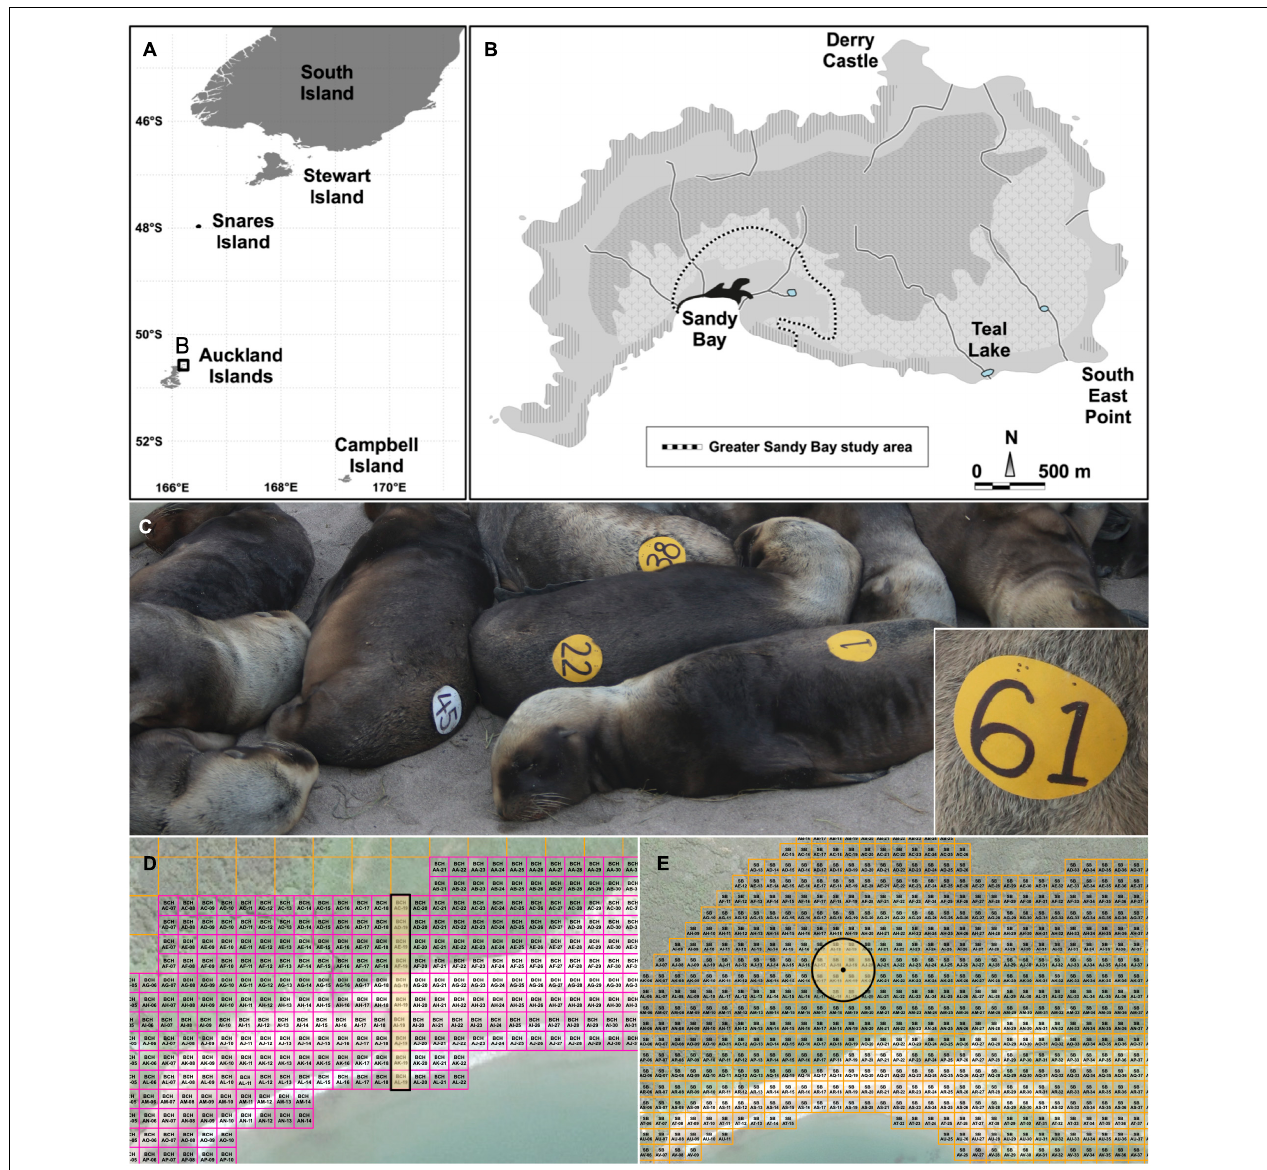
FIGURE 1 | Summary of methodology used in data collection for analysis of risk factors for mortality in New Zealand (NZ) sea lion ( Phocarctos hookeri ) pups. (A) Map of NZ sea lion breeding sites including the South Island of mainland New Zealand, Stewart Island, Auckland Islands and Campbell Island. (B) Localities of Enderby Island including the study site of greater Sandy Bay area. (C) Uniquely numbered vinyl circular discs glued to NZ sea lion pups. White discs signify cohort study animals, while all other animals were deployed with yellow discs. Inset: Braille numbers were punched into the vinyl before attachment to pups to enable identification after the written number was abraded off by sand. (D) The 10 m 2 overlaid GPS grid was used with a randomly selected north-south strip. (E) The 20 m 2 overlaid GPS grid was used with a 40 m radius from a randomly selected